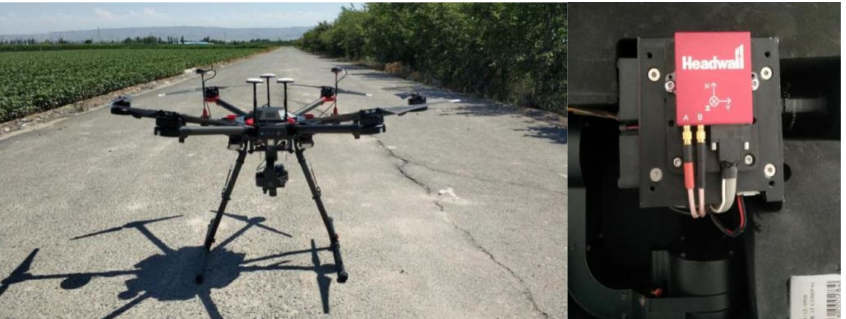
Figure 2. DJI Matrice 600 series aircraft equipped with the GPS and a sensor ( left ). The Nano- Hyperspec sensor ( right ).